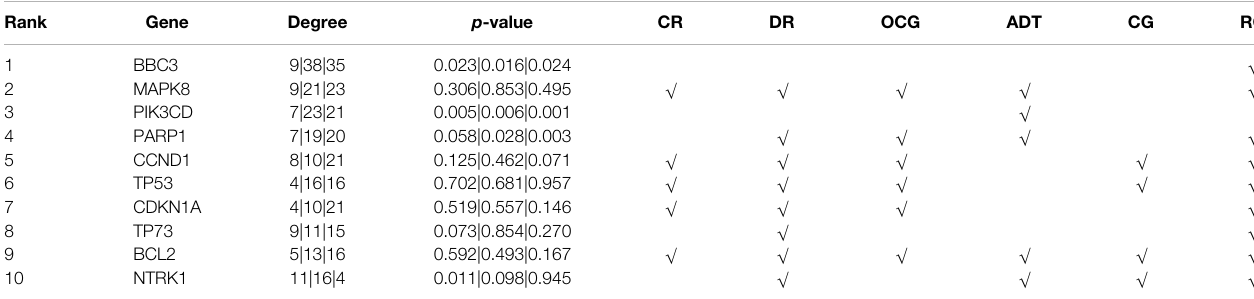
TABLE 1 | Top-10 hub genes in the estimated differential gene network between platinum-resistant and platinum-sensitive tumors. Rank Gene Degree p